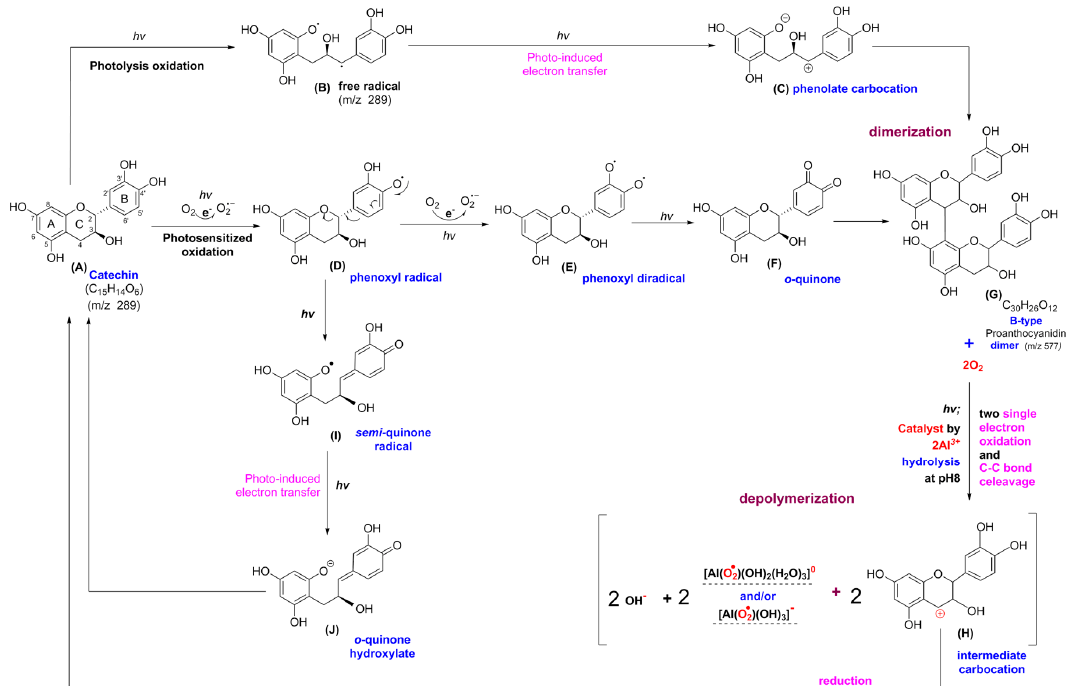
Figure 10. Proposed mechanism for the photolytic reaction of catechin upon the addition of AlCl 3 . ( A ): catechin, ( B ): free radicals at m / z 289, ( C ): phenolate carbocation, ( D ): phenoxyl radical, ( E ): phenoxyl diradical, ( F ): o -quinone at m / z 287, ( G ): B-type proanthocyanidin, ( H ): catechin carbocation, ( I ): semi -quinone radical, and ( J ): o -quinone hydroxylate.